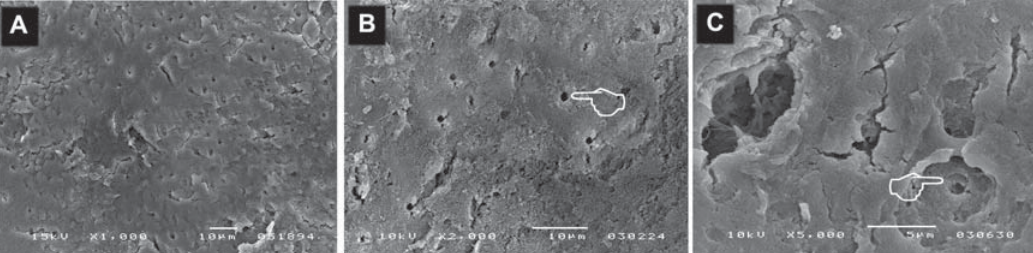
Figure 4- Scanning electron microscopy appearance of the morphology of the root surfaces treated with the simultaneous manual and ultrasonic instrumentation. Image A shows the morphology of the root surfaces characterized by very few !(cid:9)(cid:2)(cid:2)%(cid:8)(cid:5)(cid:4)(cid:13)(cid:24)(cid:25)(cid:4)(cid:5)(cid:14)(cid:8)(cid:24)(cid:25)(cid:8)(cid:9)(cid:4)(cid:9)(cid:8)"(cid:24)(cid:13)(cid:24)(cid:30)(cid:4)(cid:5)"(cid:8)(cid:13)(cid:9)(cid:4)(cid:14)(cid:13)$(cid:8)(cid:9)(cid:4)(cid:15)(cid:31)(cid:12)(cid:11)(cid:31)(cid:4)(cid:2)(cid:24)(cid:14)$(cid:4)(cid:7)(cid:13)(cid:9)(cid:30)(cid:12)(cid:13)(cid:14)(cid:14)$(cid:4)(cid:11)(cid:2)%(cid:8)(cid:9)(cid:8)(cid:25)(cid:4)(cid:30)(cid:31)(cid:8)(cid:4)(cid:9)(cid:2)(cid:2)(cid:30)(cid:4)(cid:25)(cid:8)(cid:24)(cid:30)(cid:12)(cid:24)/(cid:4)J"(cid:13)!(cid:8)(cid:4)(cid:17)(cid:28)(cid:4)(cid:13)(cid:30)(cid:4)(cid:31)(cid:12)!(cid:31)(cid:8)(cid:9)(cid:4)"(cid:13)!(cid:24)(cid:12)(cid:10)(cid:11)(cid:13)(cid:30)(cid:12)(cid:2)(cid:24)(cid:4)(cid:12)(cid:30)(cid:4) is possible to observe that the root-cementum was completely removed with the exposure of root dentin and dentin tubules (pointer). Image C shows that the remnant smear layer produced by this combined manual/sonic technique obliterated the